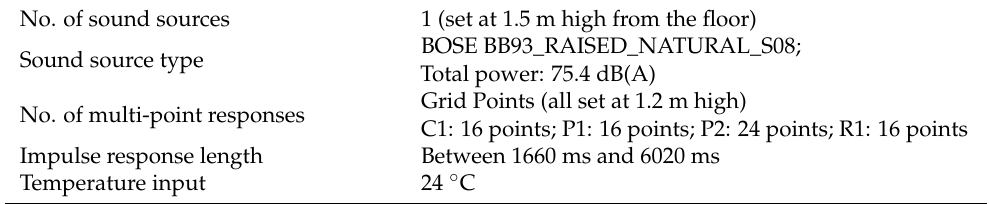
Table 5. Basic information of the simulation settings fixed in ODEON.